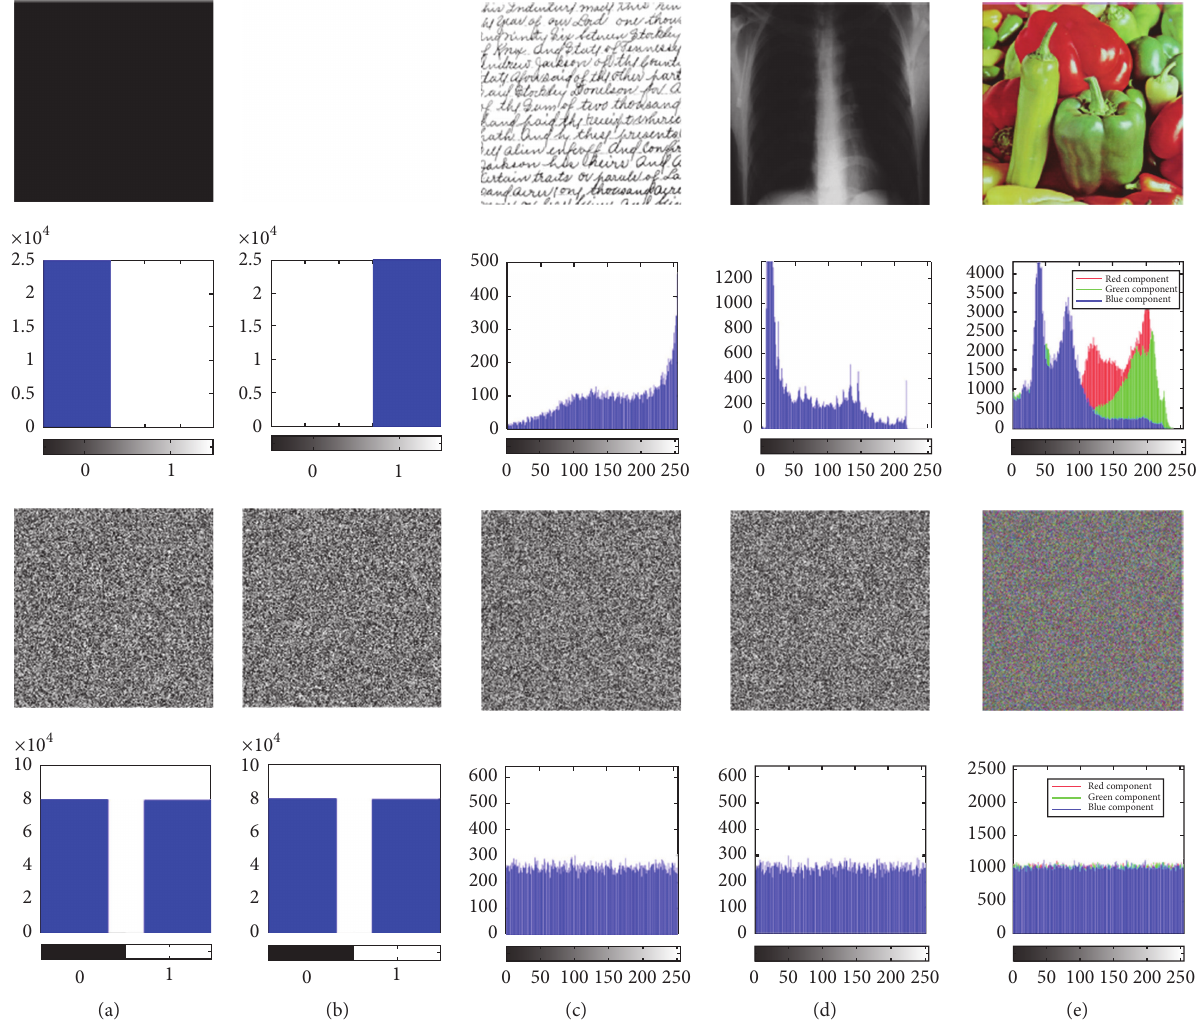
Figure 4: This figure shows simulation results of various images with their histograms: (a) all-zero pixel image; (b) all-one pixel image; (c) image with text; (d) medical image; (e) color